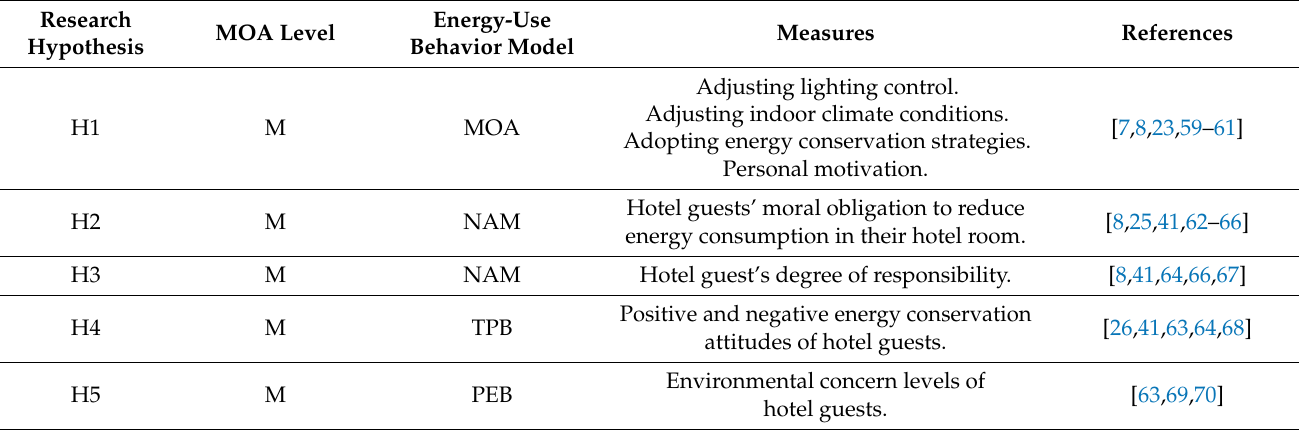
Table 1. Energy-Related Hypotheses and Measures for